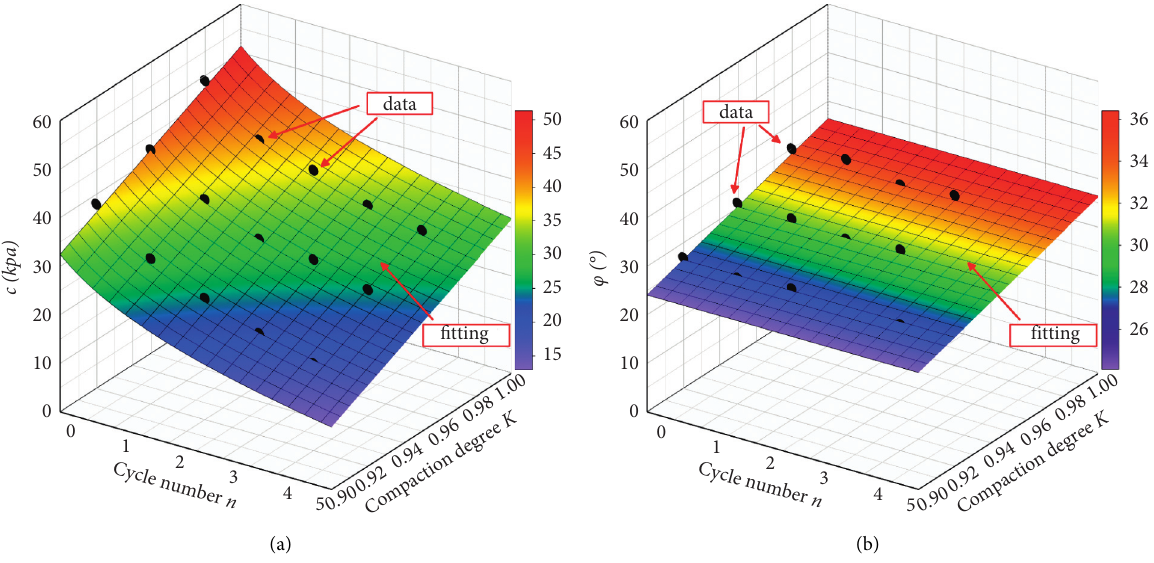
Figure 10: Influences of drying-wetting cycles and compaction degree on shear strength parameters: (a) cohesion; (b) angle of internal friction φ.